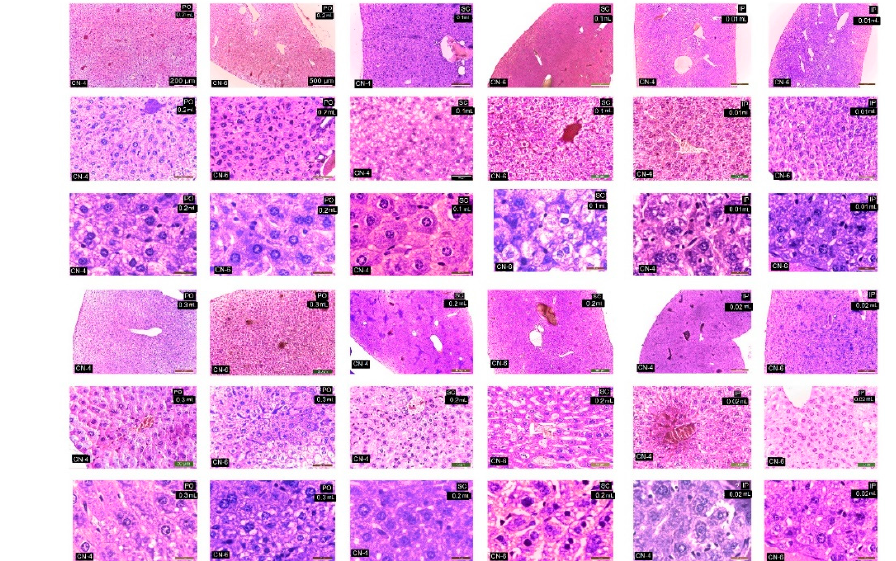
Figure 11. Histological structure of the liver in experimental groups. HE staining.